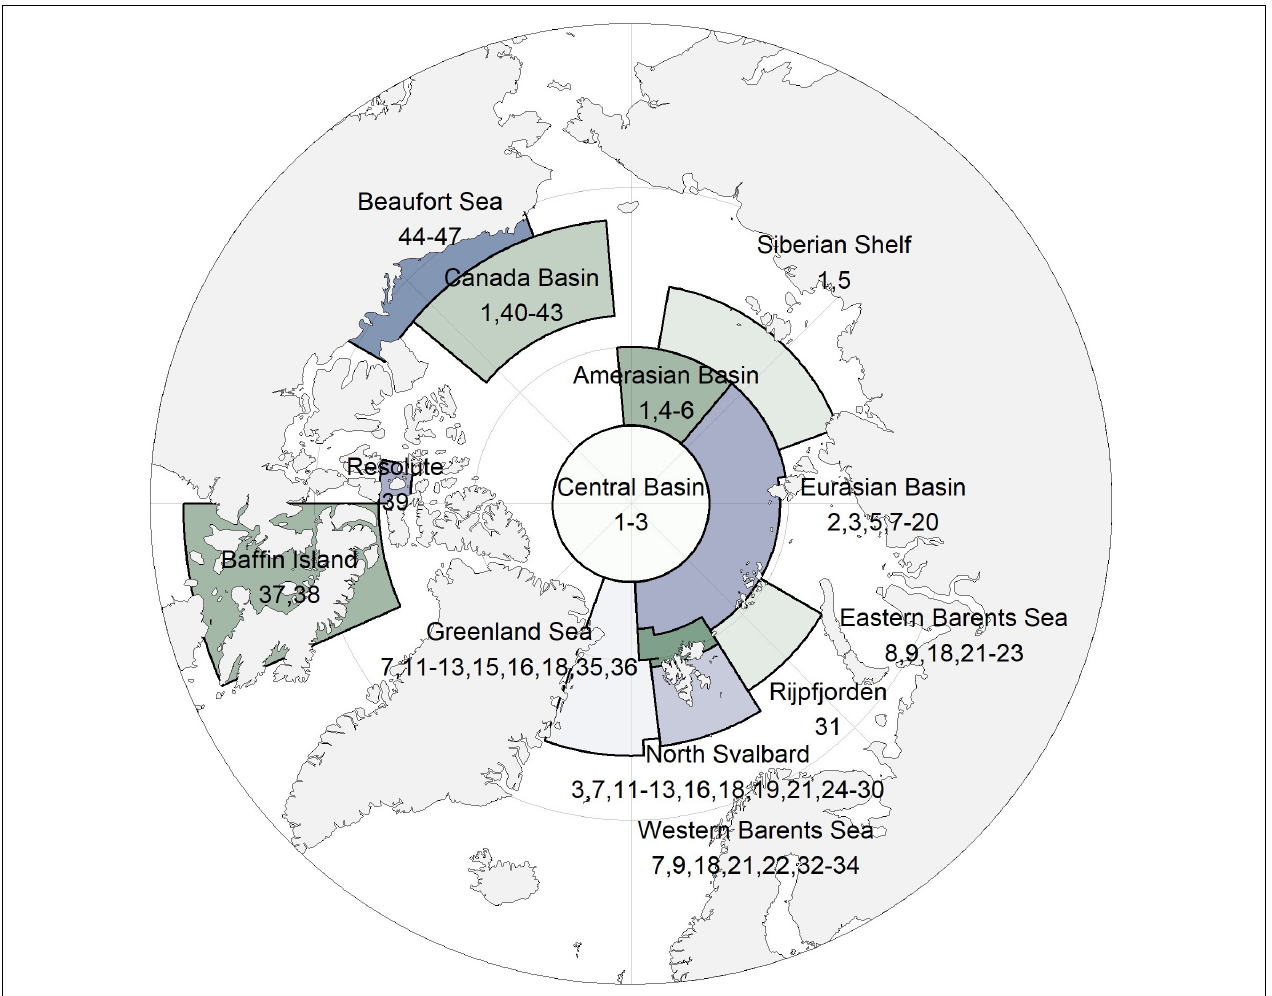
FIGURE 1 | Pan-Arctic map with study regions. Numbers refer to data sets in Table 1